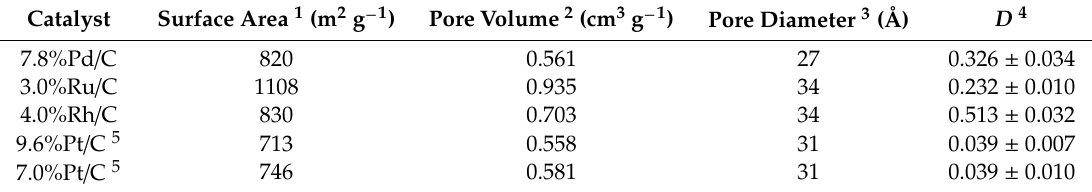
Table 6. Catalyst